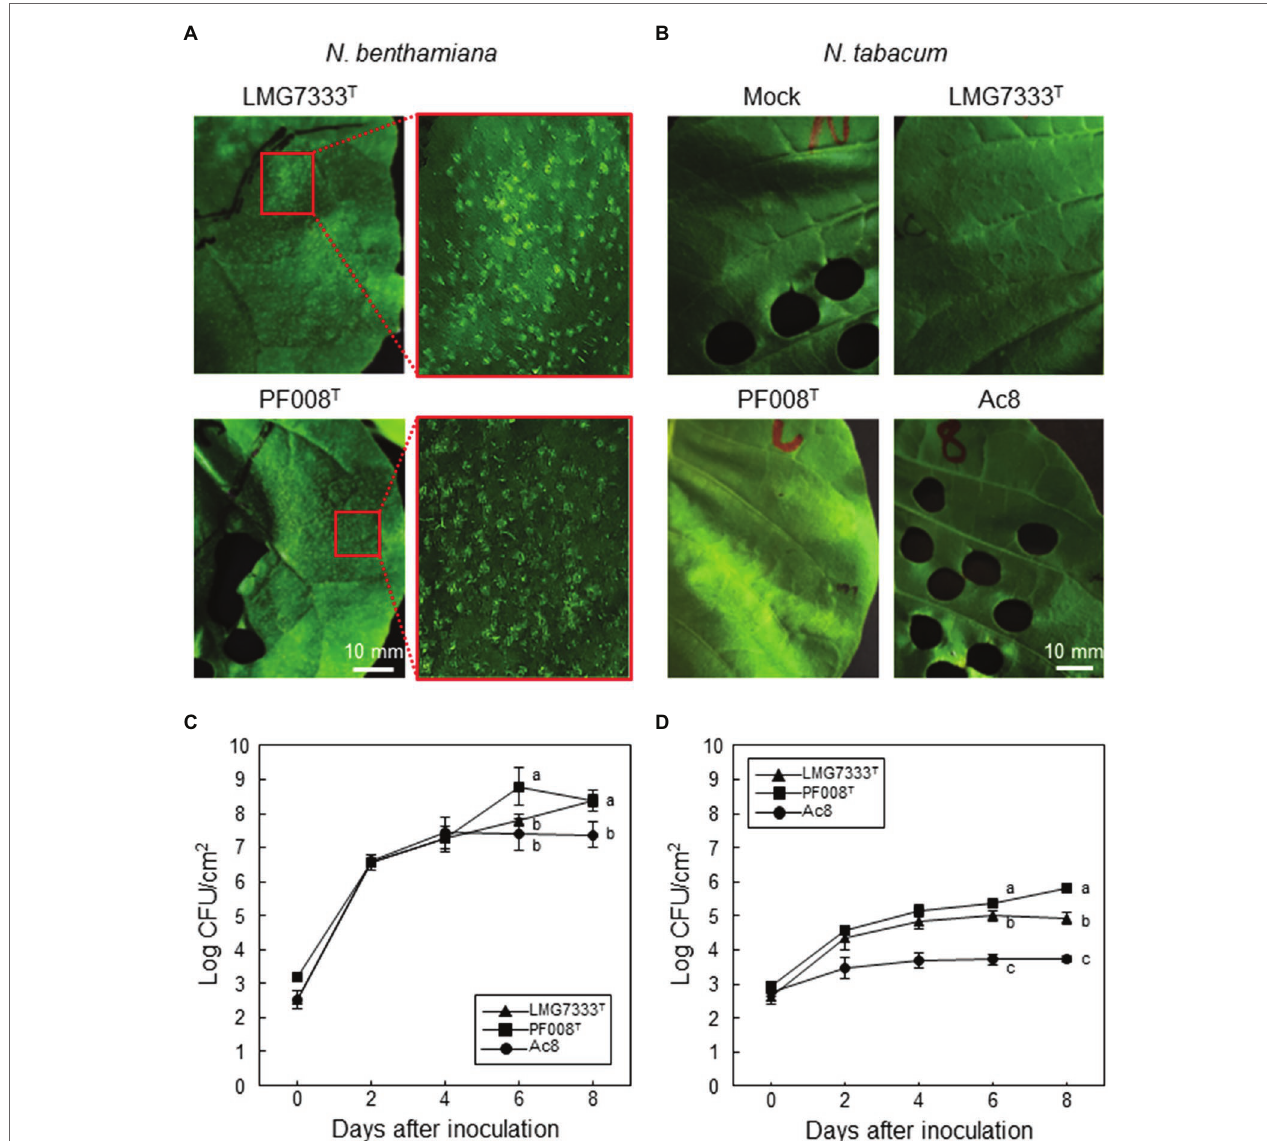
FIGURE 1 | Disease symptoms and bacterial growth in N . benthamiana and N . tabacum leaves. Both Clavibacter species induced blister-like symptoms on N . benthamiana (A) , whereas no visible symptoms were induced on N . tabacum (B) , when 5×10 4 CFU/ml of C . michiganensis LMG7333 T and C . capsici PF008 T bacterial suspensions were infiltrated. Photos were taken at 4 days after infiltration (dai). Mock, 10 mM MgCl 2 . Bacterial growth in N . benthamiana (C) and N . tabacum (D) leaves was measured at the indicated time points. The A . citrulli strain Ac8 was used as a positive control. An average and standard deviation ( n = 3) of each bacterial titer are shown in the figures. The different letters at 6 and 8 dai in the graphs indicate a statistically significant difference analyzed via Duncan’s multiple range test ( p < 0.05). Similar results were obtained from three independent assays. Scale bar = 10